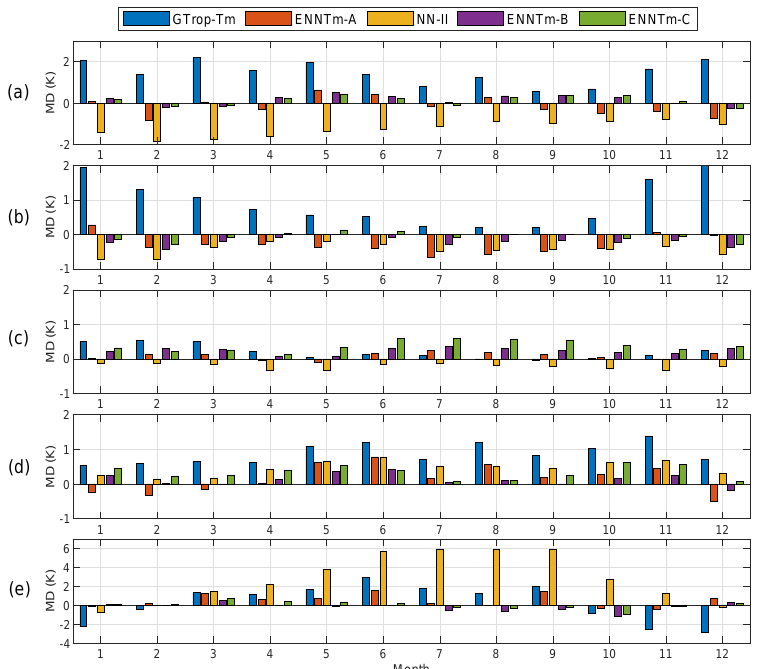
Figure 13. The statistics of MD for each model in different months in the ( a ) NFZ; ( b ) NTZ; ( c ) TZ; ( d ) STZ; and ( e )